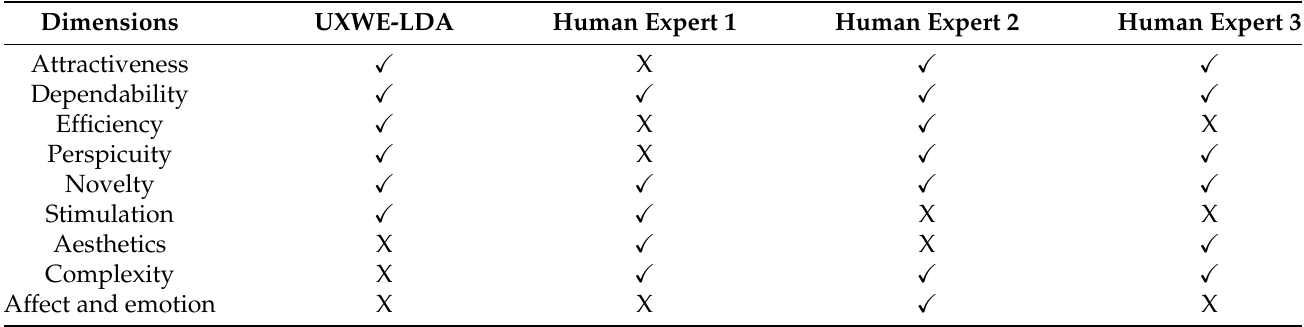
Table 5. A comparison of UXDs between UXWE-LDA model and human experts.